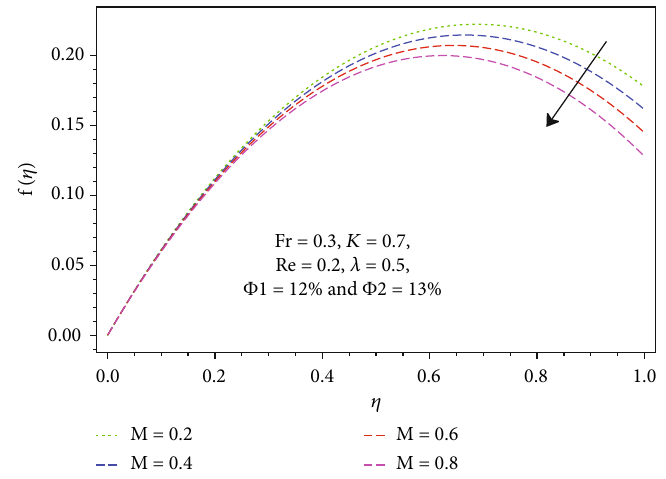
Figure 5: In fl uence of Hartmann number M over momentum pro fi le f ð η Þ